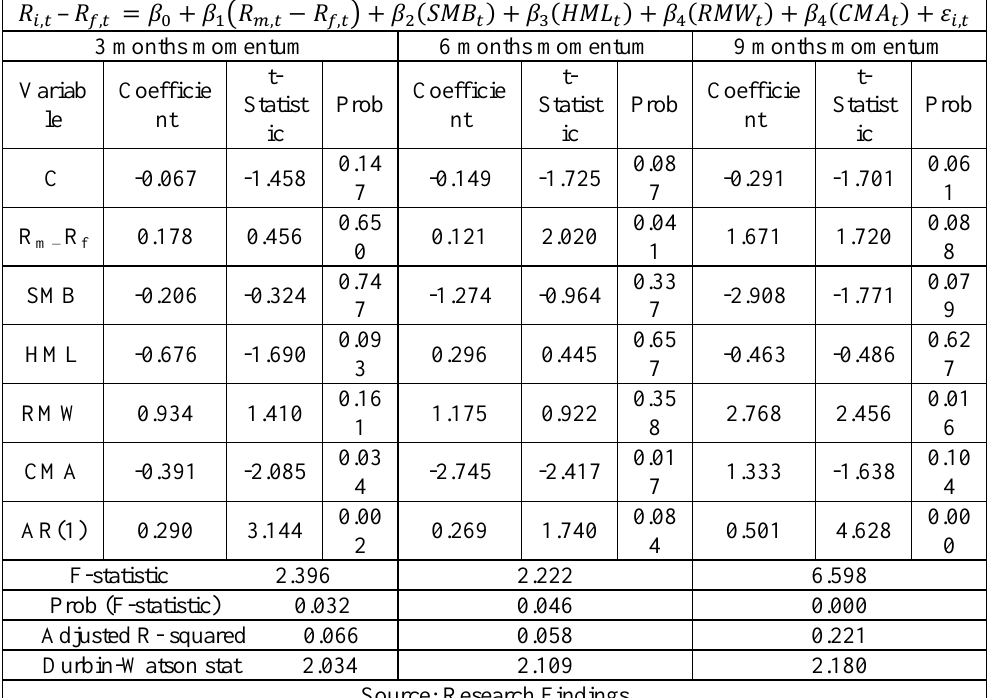
Table 9. Results of testing the fourth research hypothesis with low liquidity using